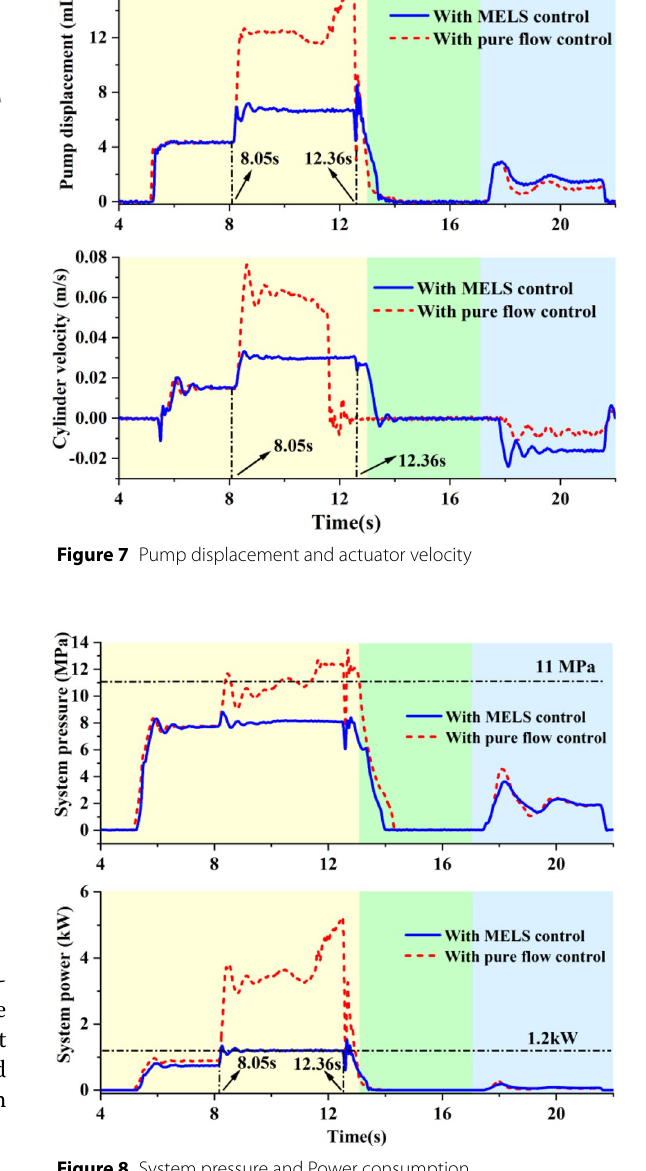
Figure 8 System pressure and Power